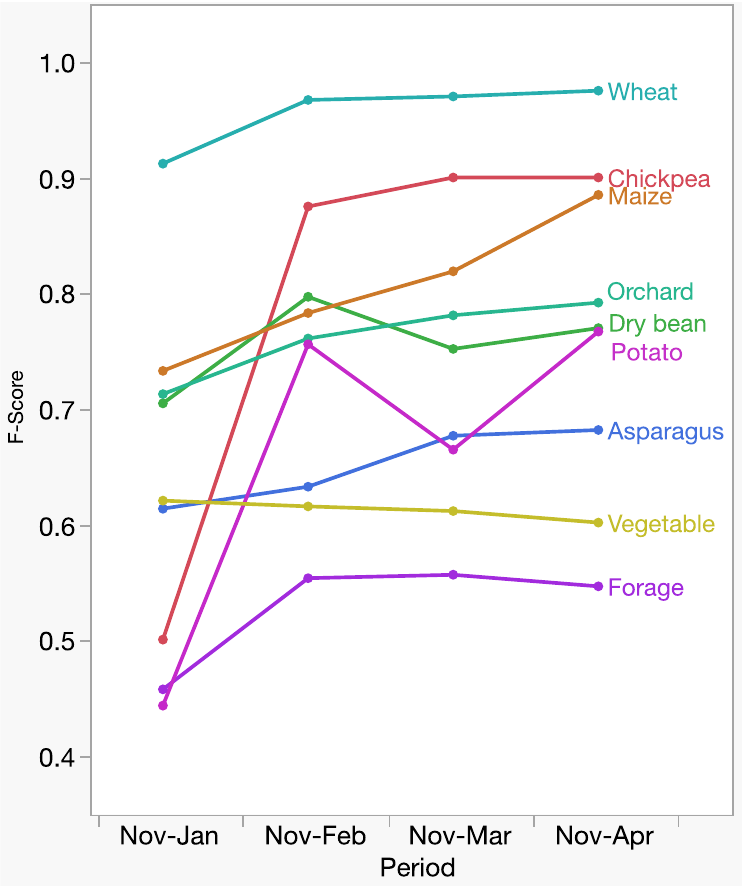
Figure 8. F-scores obtained for crop classifications spanning four different periods: The first ranged from November to January and the last from November to April.